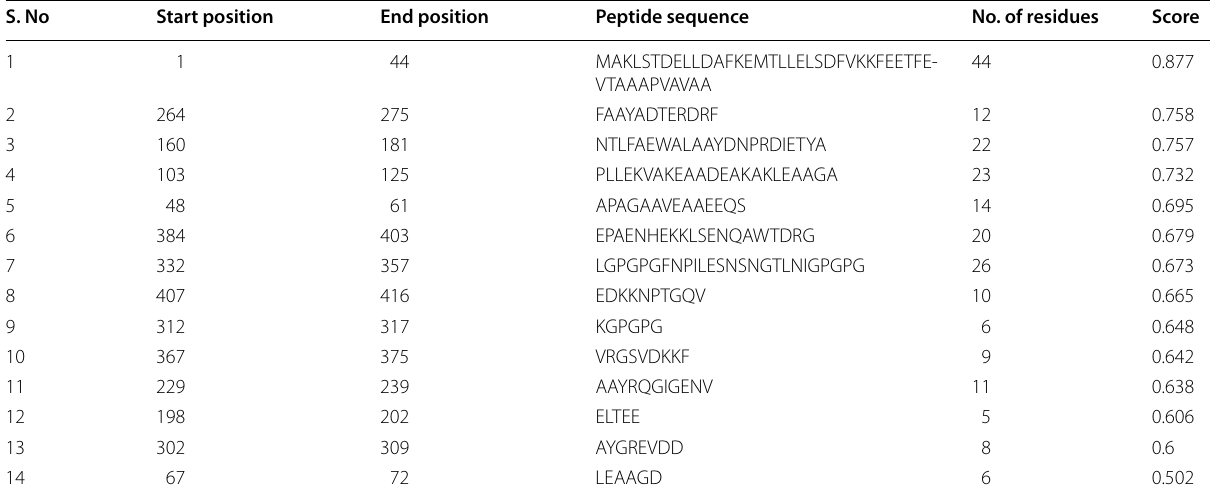
Table 7 List of conformational B cell epitopes obtained from Ellipro S. No